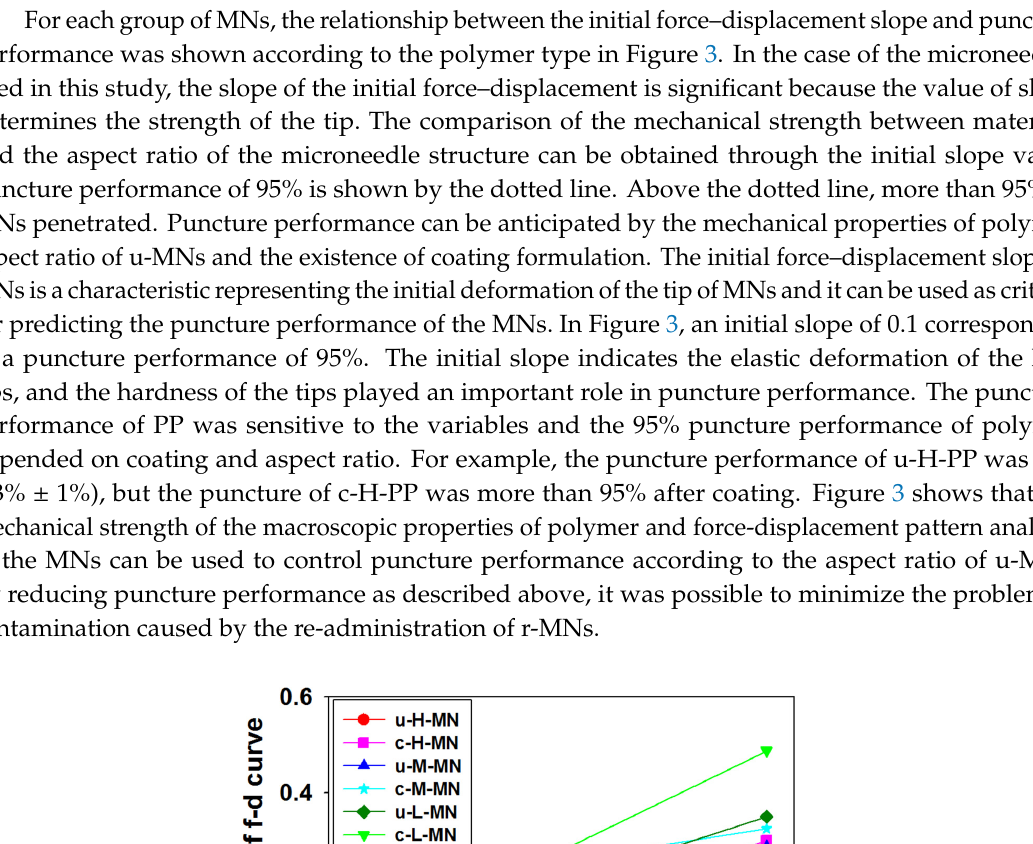
Table 5. Puncture performance of MNs according to the mechanical strength of the polymer (polyethylene (PE), polypropylene (PP), nylon (N), polylactic acid (PLA)) and the aspect ratio.